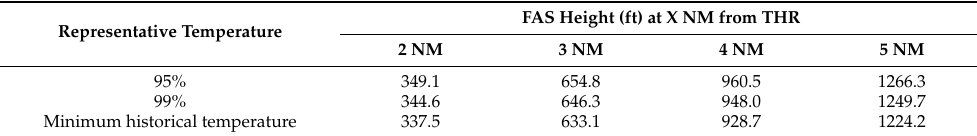
Table 8. Height of the final approach segment (FAS) at different distances from the THR. Representative Temperature